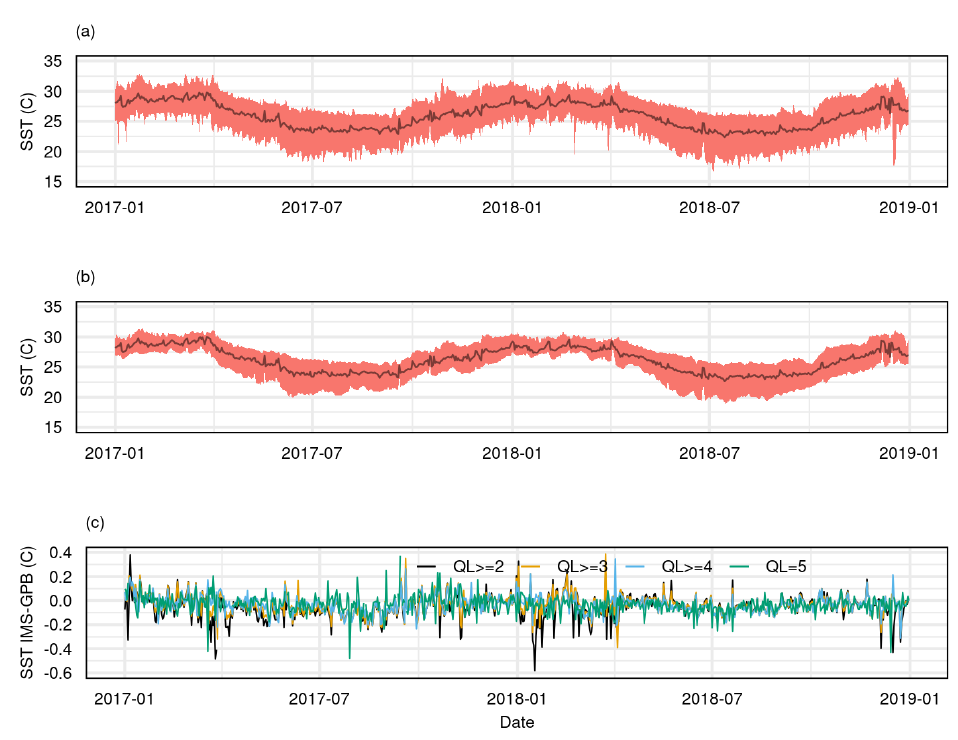
Figure 10. A comparison of IMOS Multi-sensor L3S and Geo-Polar Blended L4 over GBR Marine Park ( a ) average and range for Multi-sensor L3S (QL ≥ 3), ( b ) average and range for Geo-polar Blended SST L4 Analysis and ( c ) SST discrepancy, SST Multi-sensor Geo-polar Blend by quality. Data were sourced from